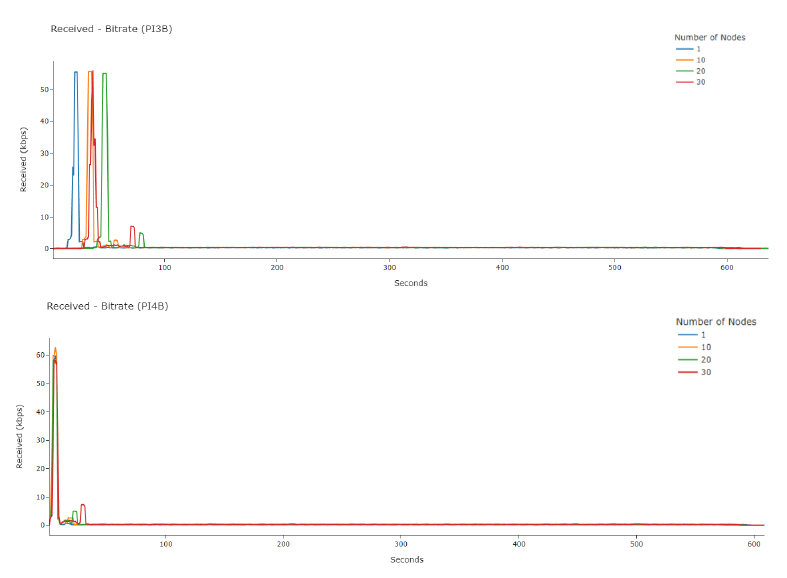
Figure 11. Sent bitrate on the Raspberry Pis 4B and 3B with each test scenario.